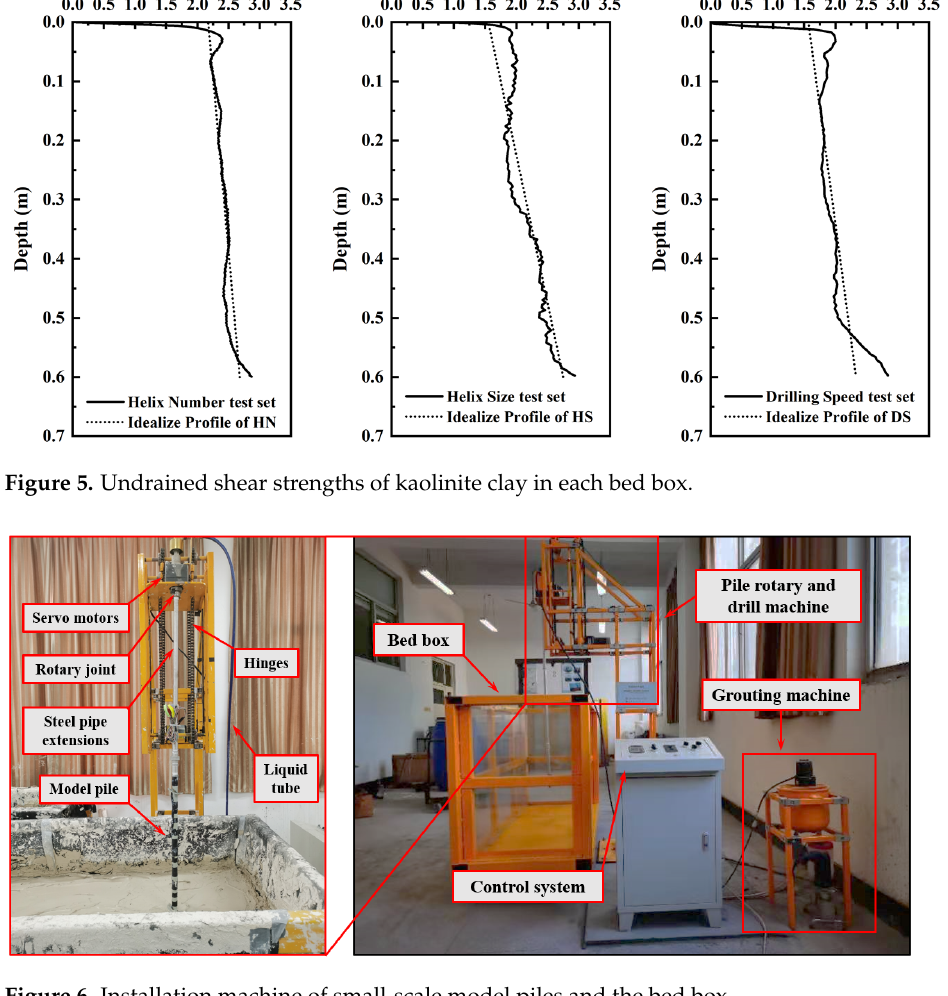
Figure 5. Undrained shear strengths of kaolinite clay in each bed box.